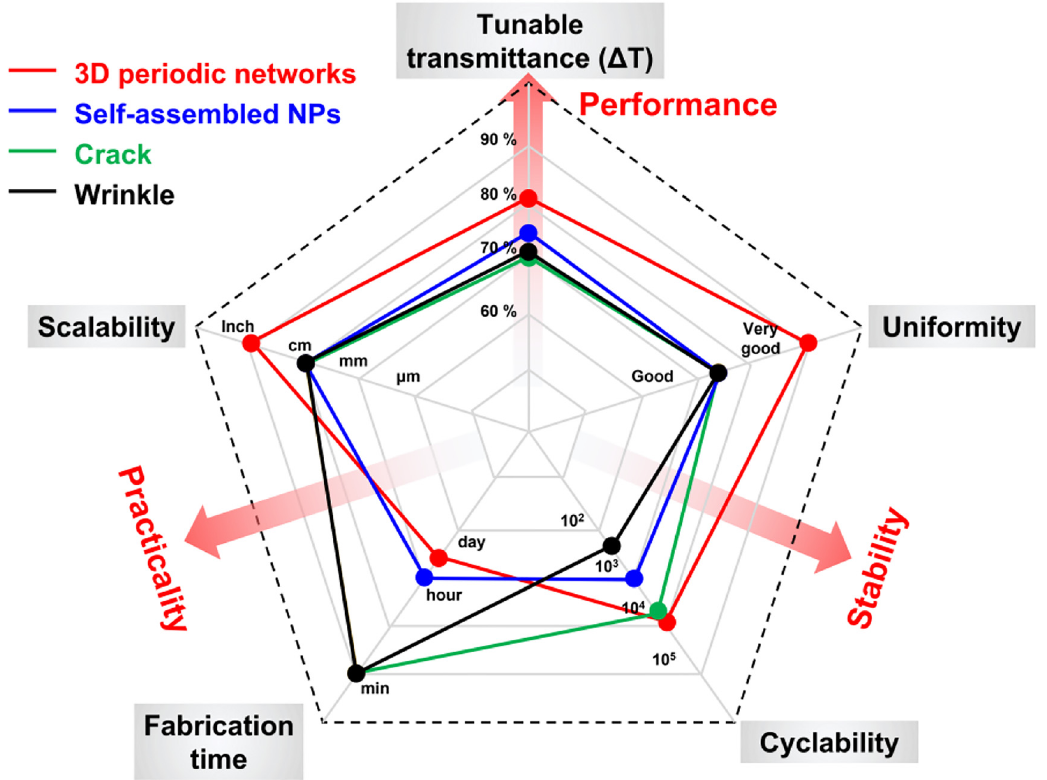
Figure 14: Perspectives for commercialization of high-performance scatterers for practical optical modulating